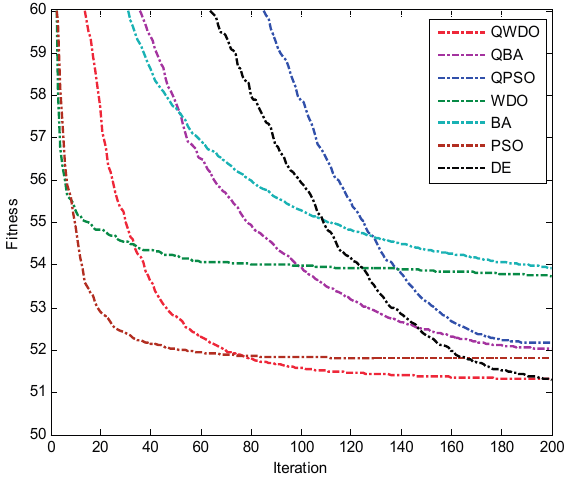
Figure 12. Fitness of the first instance for D =